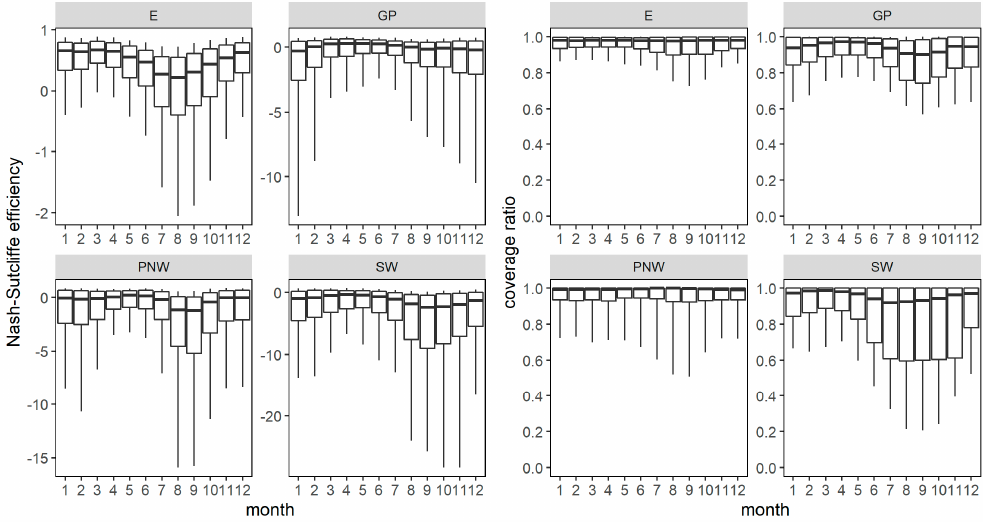
Figure 4. Monthly Nash–Sutcliffe efficiency of daily streamflow simulations and coverage ratio of 95 percent uncertainty intervals in four regions in the study area: Eastern U.S. (E), Great Plains (GP), Pacific Northwest and mountains (PNW), and Southwest (SW). Boxplot whiskers extend to the 10th and 90th percentiles of the distribution, box ends represent the 25th and 75th percentiles, and the horizontal line represents the median.